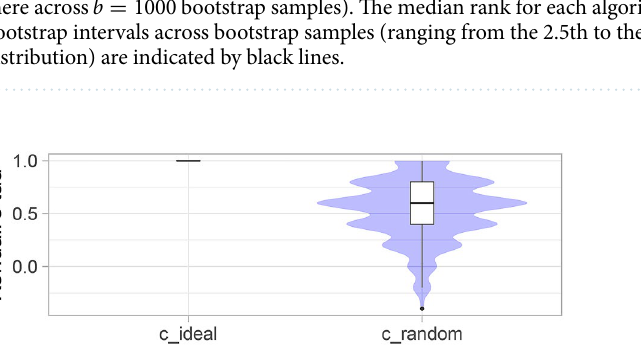
Figure 6. Violin plots for visualizing ranking stability based on bootstrapping. The ranking list based on the full assessment data is compared pairwise with the ranking lists based on the individual bootstrap samples (here b = 1000 samples). Kendall’s τ (cf. “Comparison and aggregation of rankings”) is computed for each pair of rankings, and a violin plot that simultaneously depicts a boxplot and a density plot is generated from the